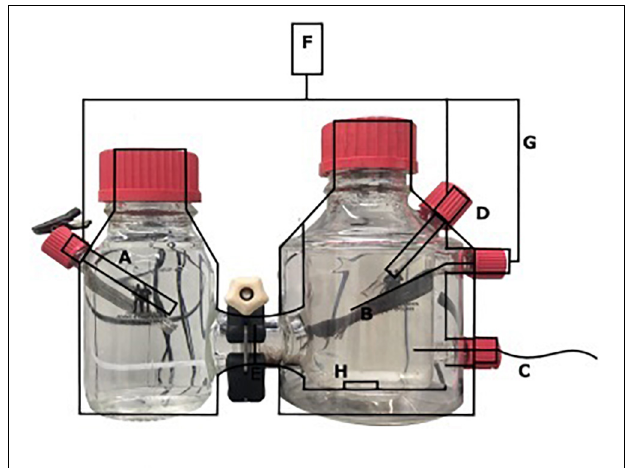
FIGURE 1 | Schematic overview of the BES with (A) stainless steel cathode, (B) carbon cloth anode (7.2 × 2.5 cm), (C) Gas-in CH 4 /CO 2 95%/5%, N 2 > 99% (D) Ag/AgCl reference electrode, (E) nafion cation exchange membrane, (F) potentiostat, (G) platinum wire, and (H) stirring